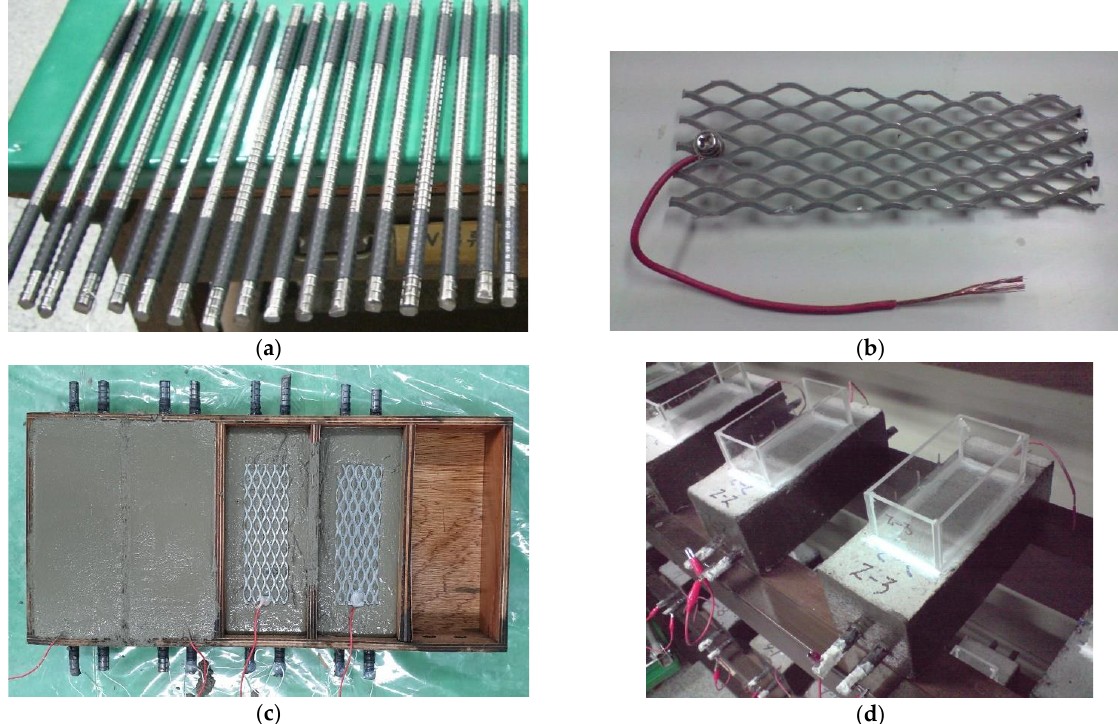
Figure 8. Specimen production with rebar and Zn mesh anode for CP performance evaluation. ( a ) Rebar; ( b ) Zn mesh anode; ( c ) Specimen preparation; ( d ) Manufactured